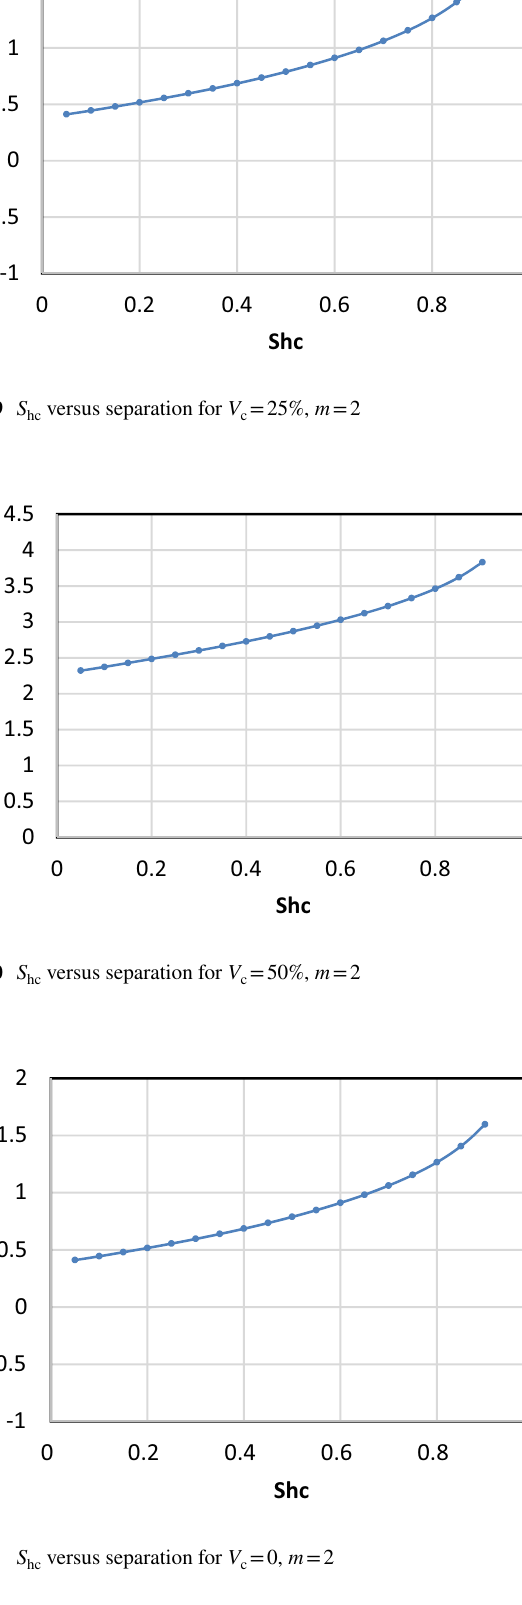
hc versus separation for